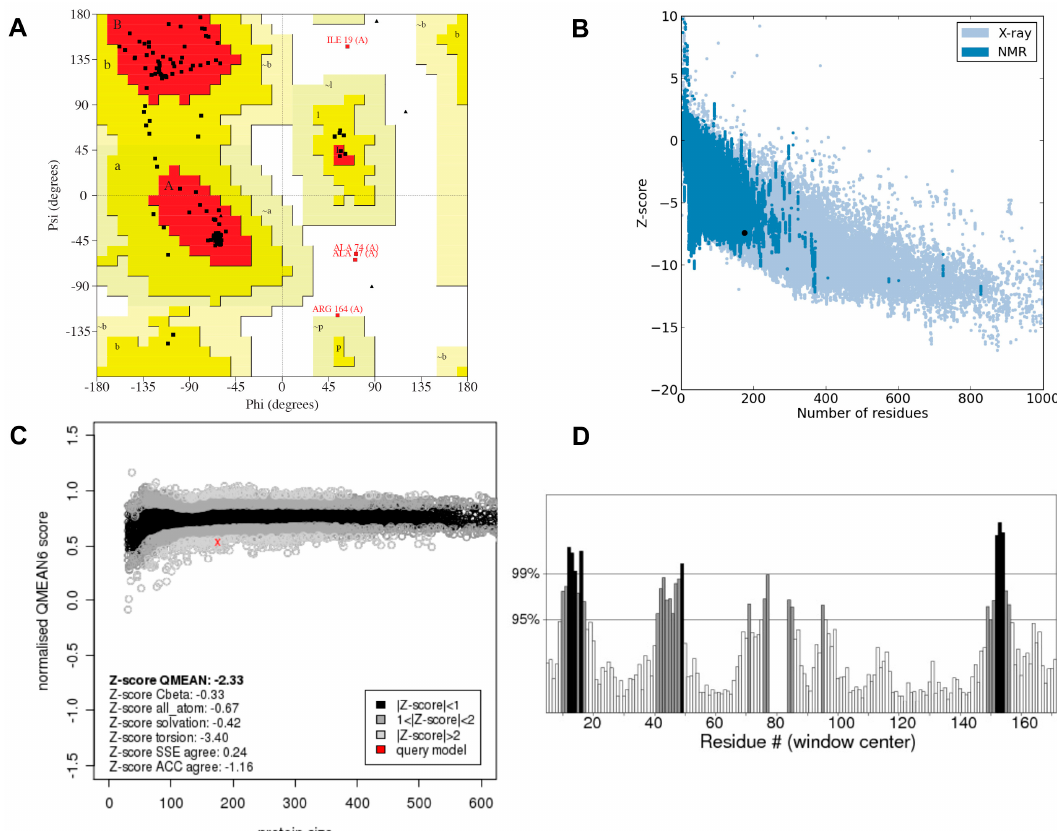
Figure 3. Validation of the CsTegu20.6 3D model. ( A ) The Ramachandran plot shows the residue in most favored regions (85.5%), additional allowed regions (11.9%), generously allowed regions (0.1%) and disallowed regions (2.5%). Red (A, B, L), yellow (a, b, l, p) and light yellow (~a, ~b, ~l, ~p) indicate the most favored regions, allowed regions and generously allowed regions. White shows disallowed regions. All non-glycine and non-proline residues are shown as closed black squares while glycines (non-end) are shown as closed black triangles. Disallowed residues are colored in red; ( B ) the ProSA energy profile indicates that the Z-score was − 7.41; ( C ) the QMEAN Z-score is − 2.33; ( D ) in the ERRAT plot, the overall quality factor is 80.75%.